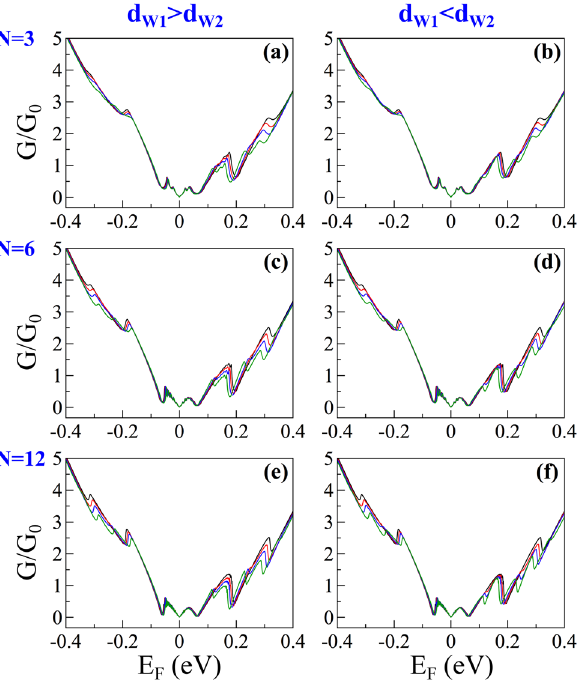
Figure 16. Conductance versus the Fermi energy of BPGGSLs for different number of periods N as indicated. In the left column ( d W 1 > d W 2 ) d W 2 is fixed to 50 a and d W 1 takes values of 50 a , 55 a , 60 a and 70 a , black, red, blue and dark-green lines, respectively. In the right column ( d W 1 < d W 2 ) the roles between d W 1 and d W 2 are reversed. In all cases, the other superlattice parameters are: d B = 50 a and V 0 = 0.13